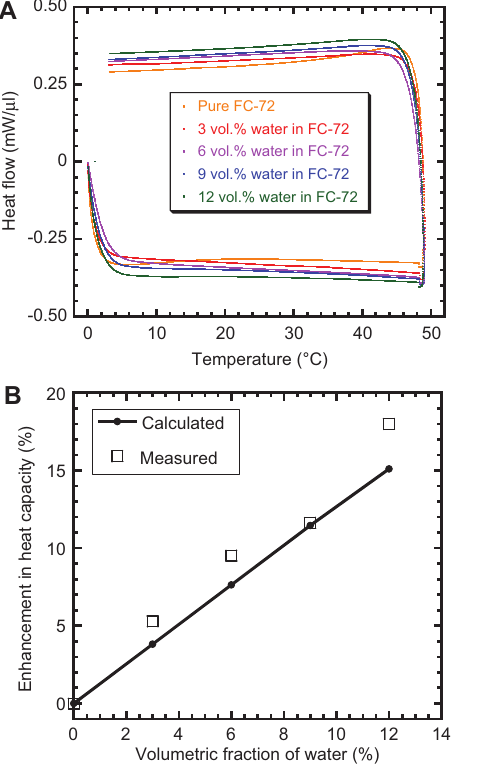
Figure 12 (A) The DSC cyclic curves of the pure FC-72 and FC-72 nanoemulsion fluids. (B) The measured and calculated heat capacity of the water in the FC-72 nanoemulsion fluids. The dispersed water droplets remain in the liquid phase during the operation.